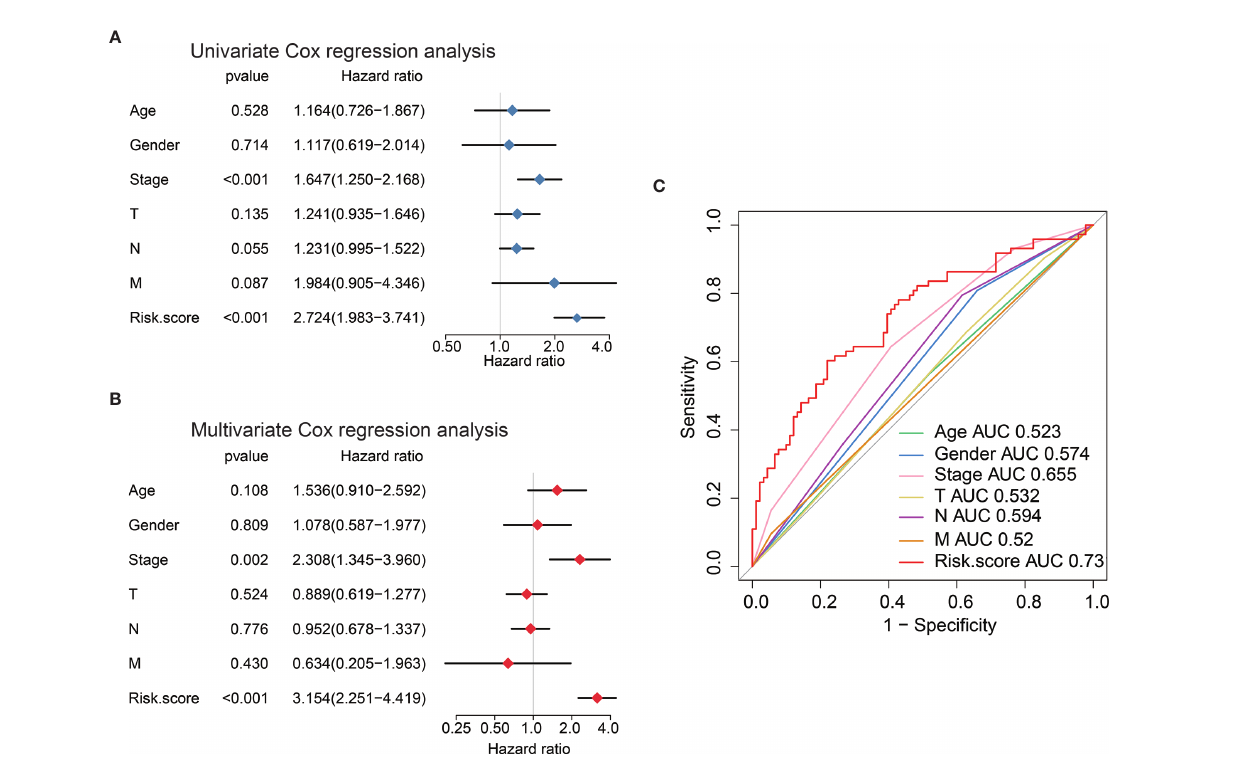
FIGURE 6 | Univariate and multivariate analysis shows the prognostic value of 6-lncRNA signature. Univariate (A) and multivariate (B) Cox regression analyses of the association between clinicopathological factors and OS of AEG patients. (C) The receiver operator characteristic (ROC) curves to predict the sensitivity and speci fi city of clinicopathological factors and 6-lncRNA signature-derived risk scores in AEG